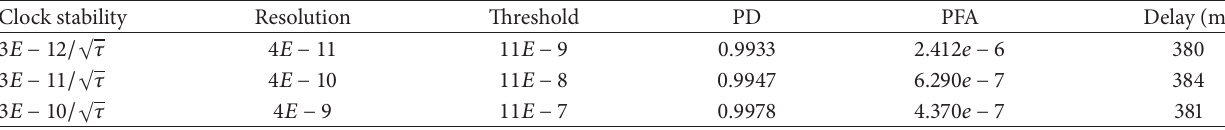
Table 4: Detection performance of frequency jumping for different clock